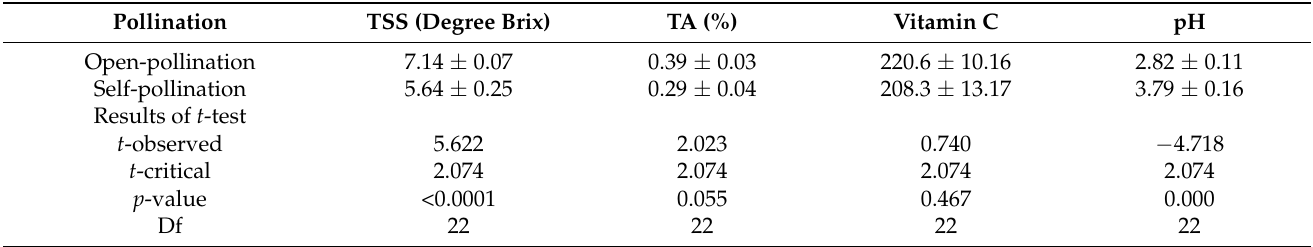
Table 5. Comparison of means ( ± SE) of chemical parameters of strawberry fruits between open- and self-pollination